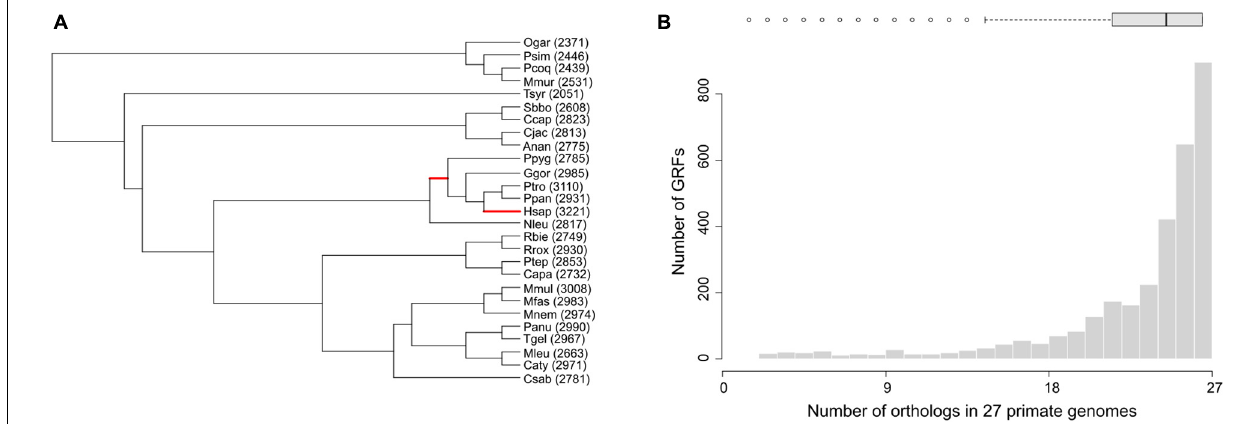
FIGURE 1 | (A) Schematic representation of the primate species tree used for the analyses, based on 10 kTrees (Arnold et al., 2010), with analyzed branches (human and great apes) shown in red color. Branch lengths do not represent evolutionary distances. The number of GRFs within specific genomes that was included in the analyses, after filtering the read-throughs and recent duplications, is given in brackets following the species abbreviation. Species abbreviations: Ogar, Otolemur garnetti ; Psim, Prolemur simus ; Pcoq, Propithecus coquereli ; Mmur, Microcebus murinus ; Tsyr, Tarsius syrichta ; Sbbo, Saimiri boliviensis ; Ccap, Cebus capucinus ; Cjac, Callithrix jacchus ; Anan, Aotus nancymaae ; Ppyg, Pongo abelii ; Ggor, Gorilla gorilla ; Ptro, Pan troglodytes ; Ppan, Pan paniscus ; Hsap, Homo sapiens ; Nleu, Nomascus leucogenys ; Rbie, Rhinopithecus bieti ; Rrox, Rhinopithecus roxellana ; Ptep, Piliocolobus tephrosceles ; Capa, Colobus angolensis palliates ;